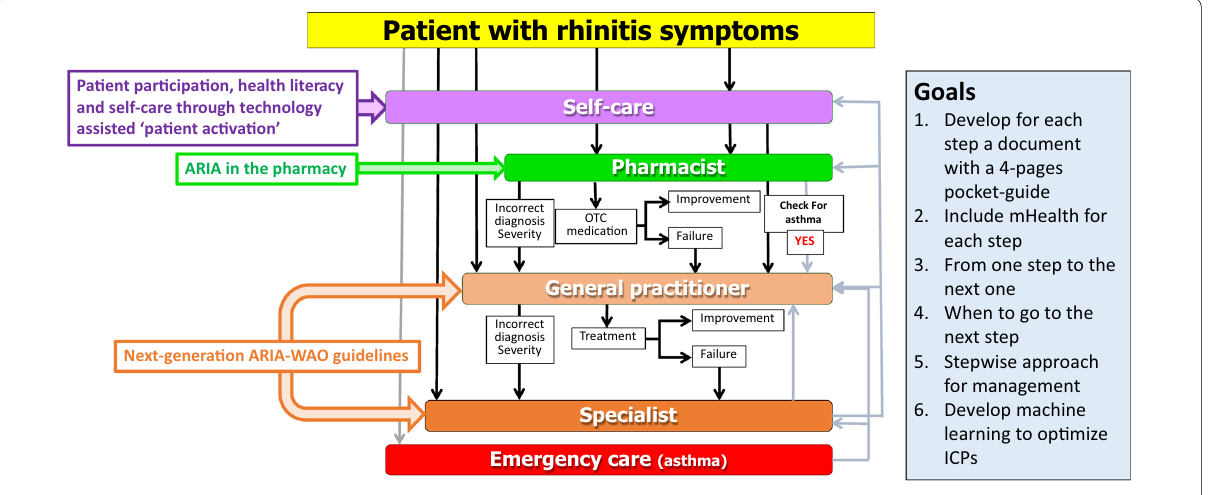
Fig. 4 Next‑generation care pathways. From